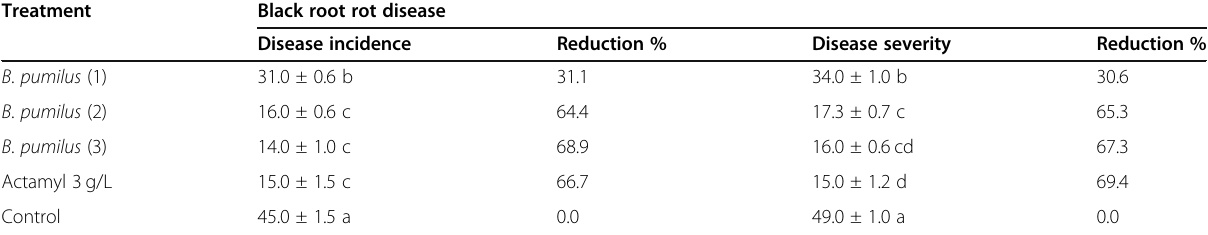
Table 2 Effect of some Bacillus pumilus isolates on black root rot disease of strawberry plants under field conditions